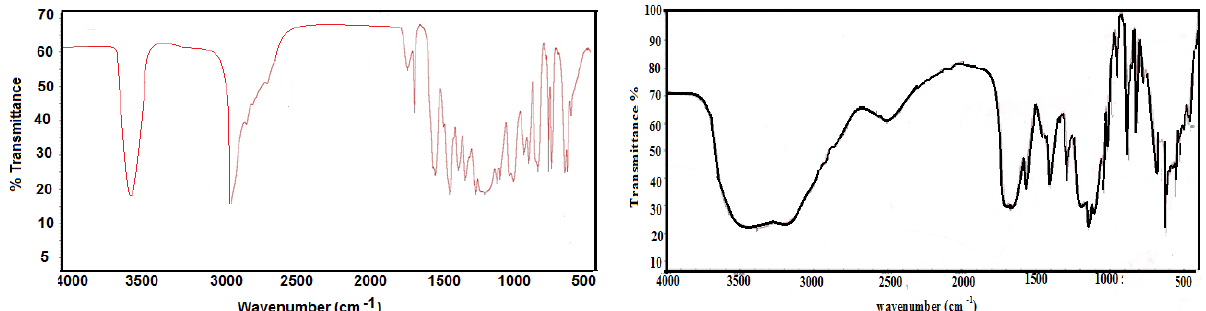
Figure 1. FTIR spectra of ( a ) PVA and ( b ) PVA-SH.